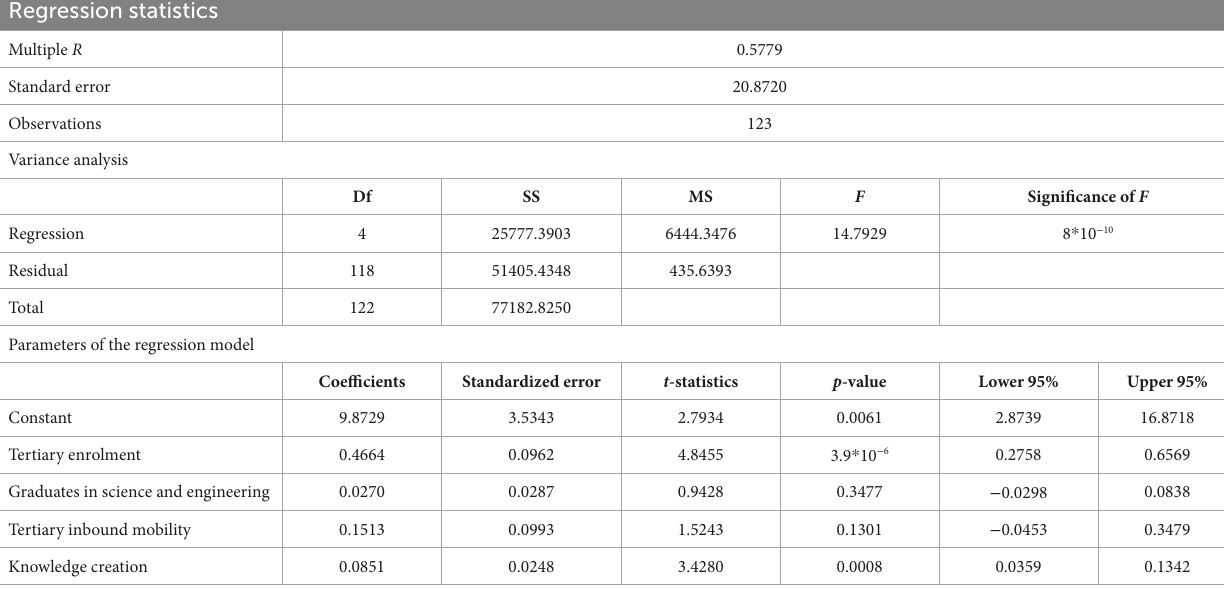
TABLE 1 Regression analysis of the dependence of high-tech manufacturing on university management factors in